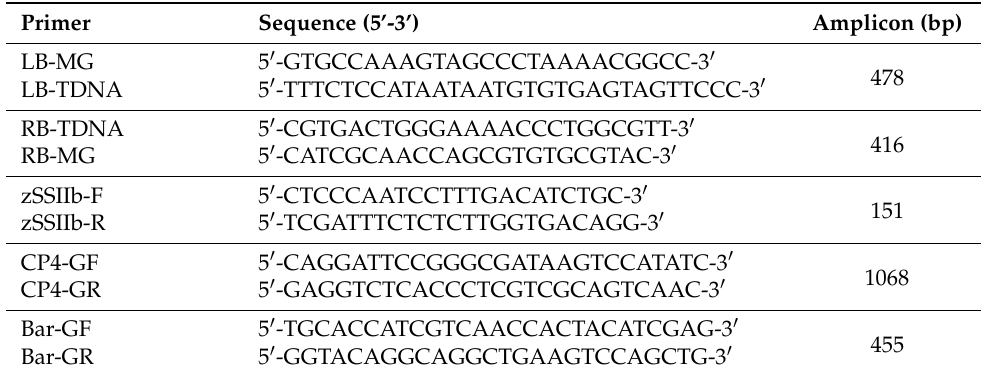
Figure 2. Pedigree diagram of event SCB-29 and control seed materials. Table 1. Primers for PCR